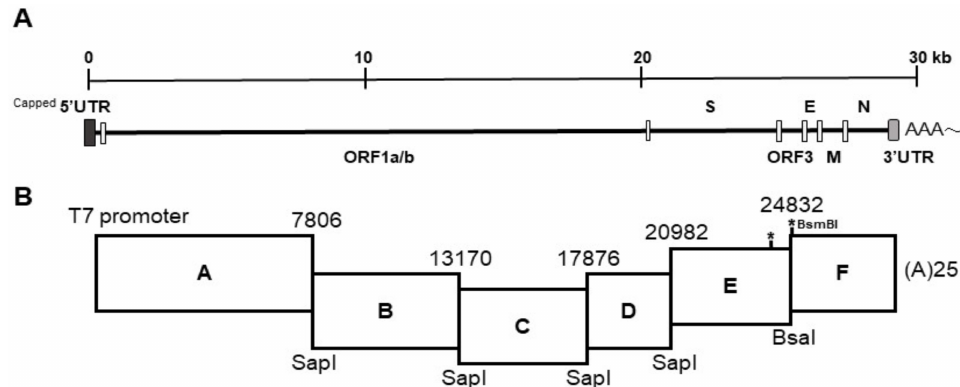
Figure 1. The schematic diagram of the PEDV genome and the cloning strategy for construction of the infectious PEDVPT-P96 clone. ( A ) Organization of the complete PEDV genome. ( B ) Six fragments were joined with specific restriction enzymes as labeled and the corresponding nucleotide sites are